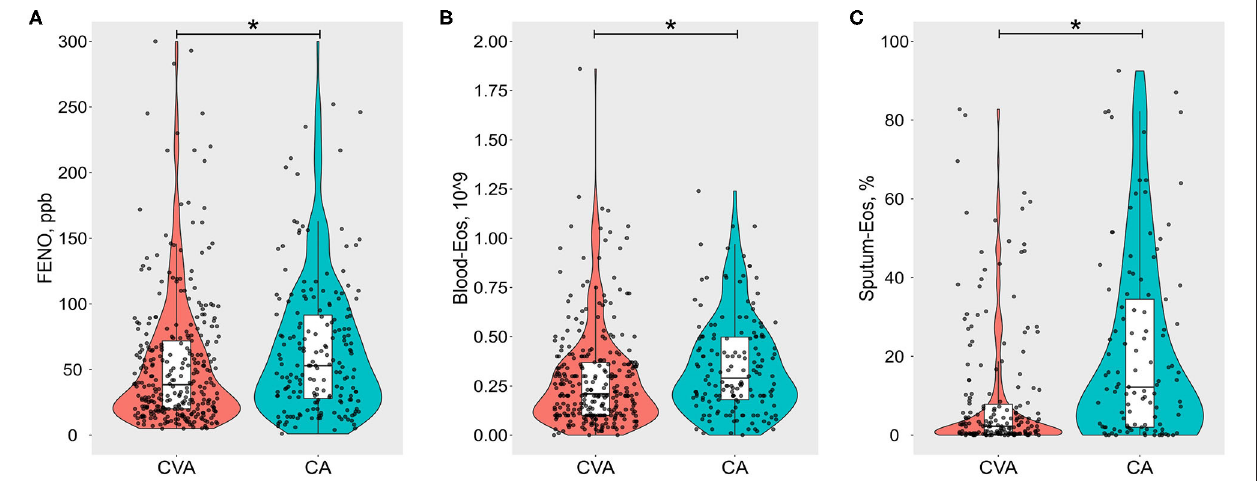
FIGURE 2 | Violin-boxplots of (A) fractional exhaled nitric oxide (FENO, ppb), (B) blood eosinophil count per 10 9 (Blood-Eos), and (C) sputum eosinophil % (Sputum-Eos) between cough variant asthma (CVA) and classic asthma (CA). The boxes represent median and interquartile range values. Raw data are denoted by black dots, each representing one subject. *Refers to p <